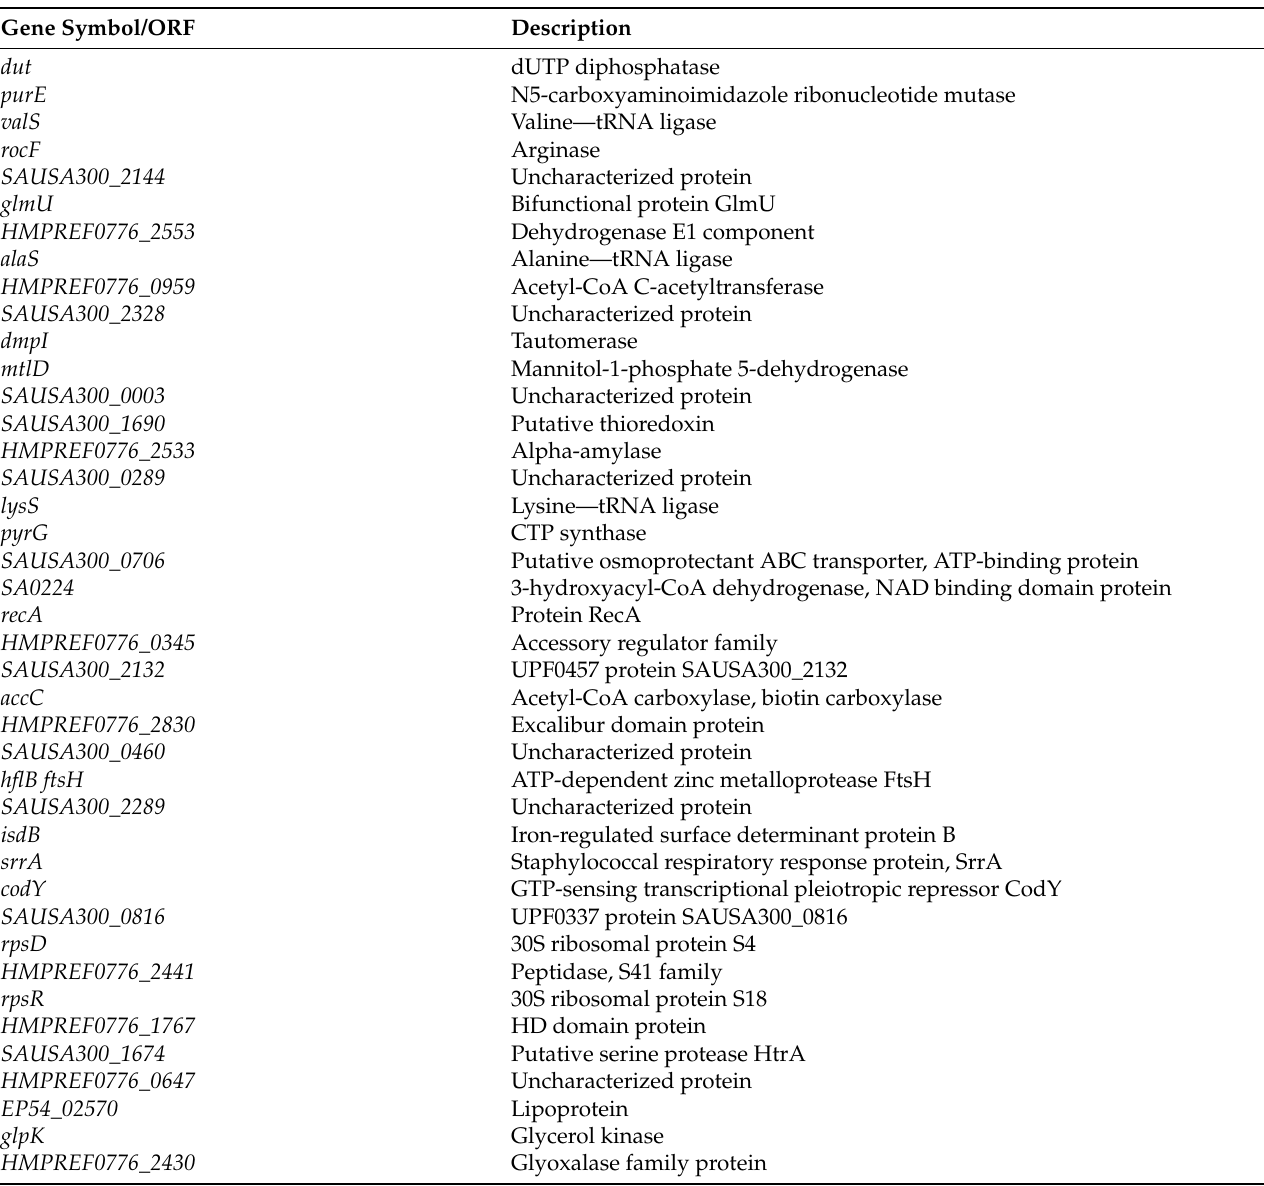
Table 2. Unique proteins associated with MVs isolated from MRSA, grown in the presence of sub-MIC VAN (0.5 mg/L). Gene